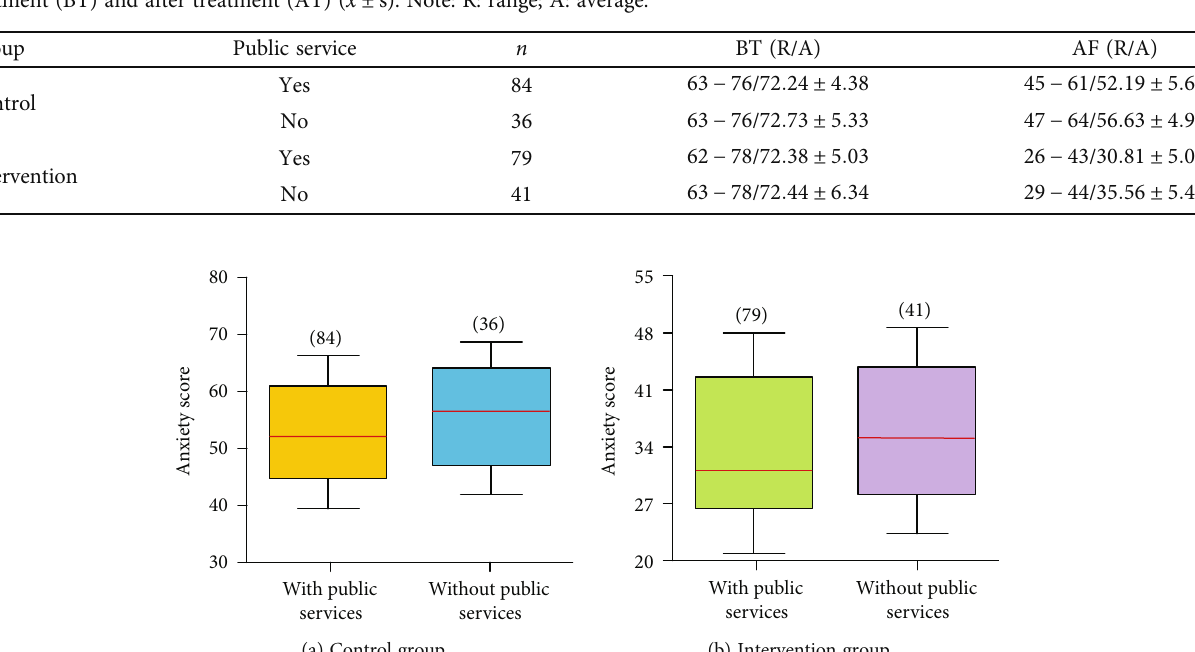
Table 7: Comparison of anxiety evaluation results of college students with di ff erent public service experiences in the two groups before treatment (BT) and after treatment (AT) ( (cid:1) x ± s ). Note: R: range; A: average.